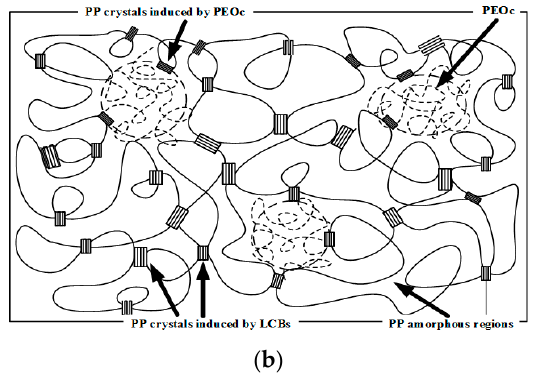
Scheme 1. Schematic illustration of the crystallization patterns for ( a ) iPP/PEOc blends; and ( b )